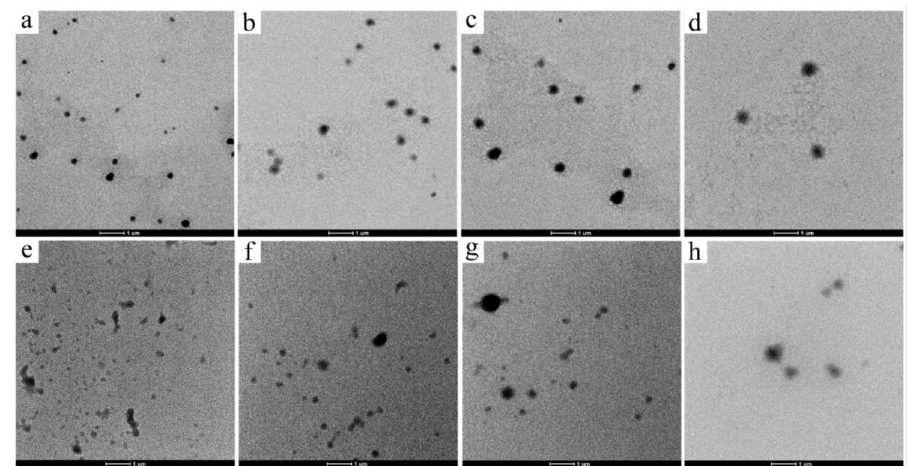
Figure 3. TEM images for morphological observation. ( a – d ) is the TEM images of LMP-CSLG nanocomplex particle with different CSLG concentration (0.5, 1.0, 2.5, and 5.0 mg/mL); ( e – h ) is the TEM images of HMP-CSLG nanocomplex particle with different CSLG concentration. Transmission Electron Microscopy (TEM); low methoxyl pectin (LMP); cationic short linear glucan (CSLG); high methoxyl pectin